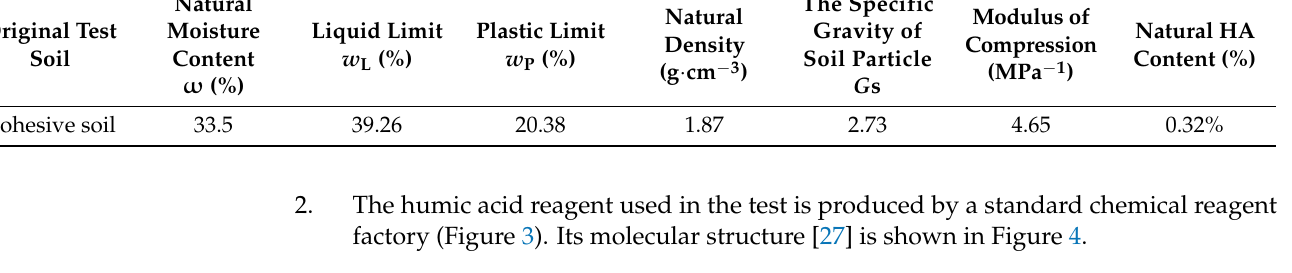
Table 1. Physical and mechanical properties index of undisturbed soil for testing.